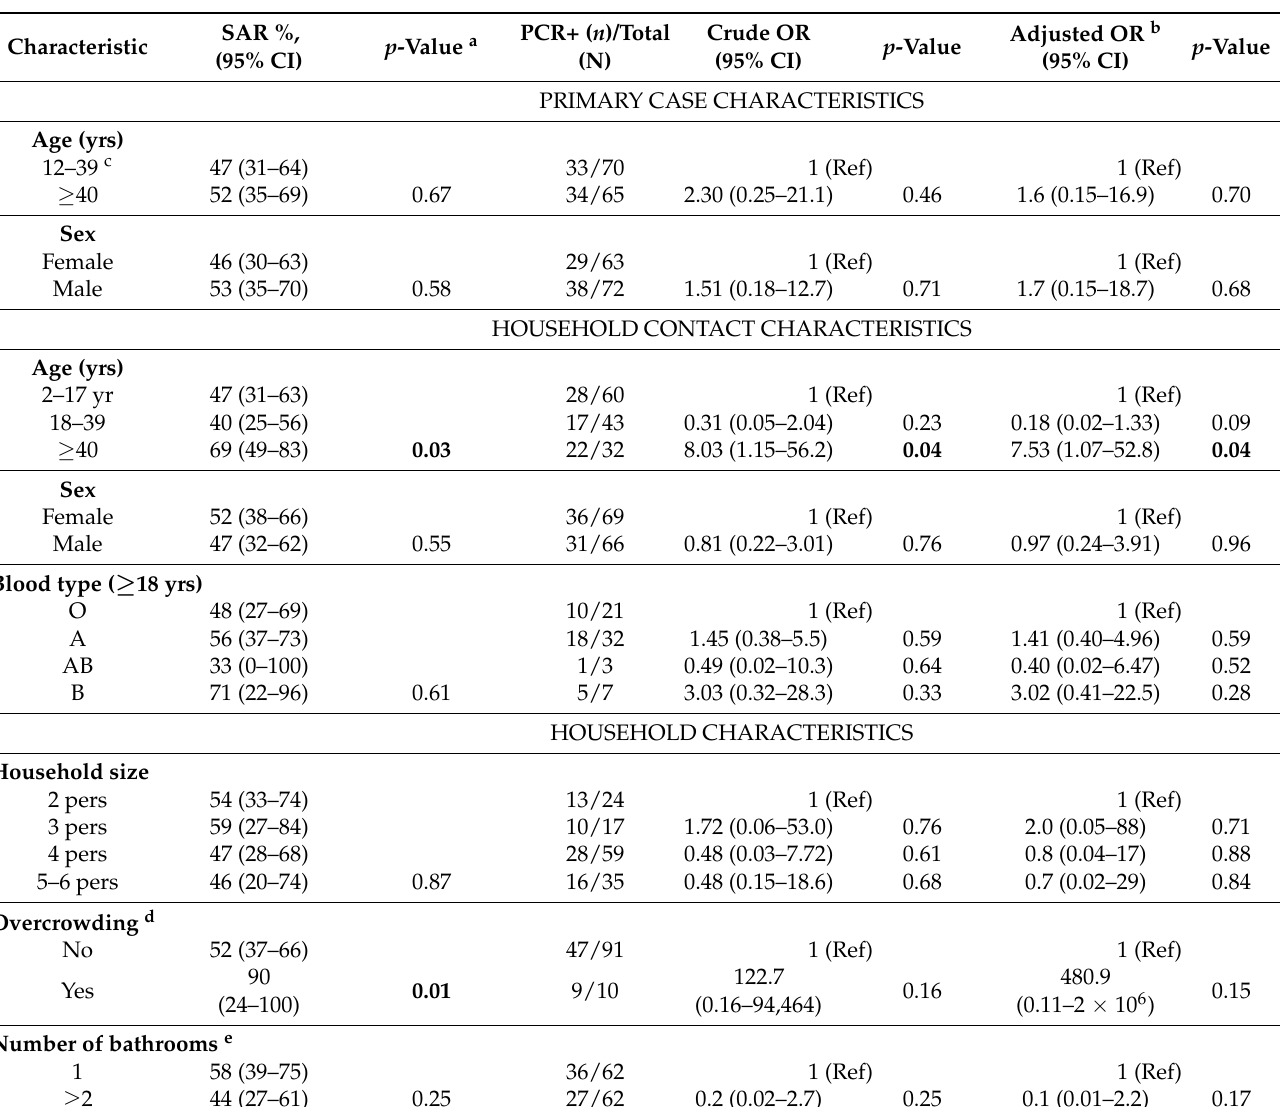
Table 3. Secondary attack rates (SAR) and odds ratios (OR) for secondary infection of all household contacts (N = 135) according to characteristics of primary case, household contact characteristics, and household